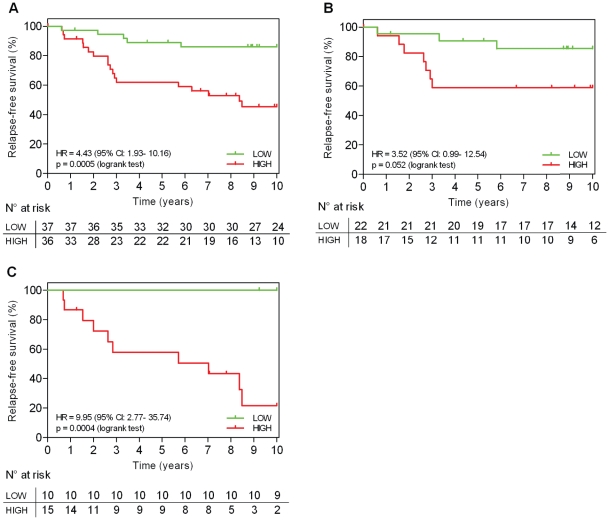
Kaplan-Meier analyses for relapse-free survival according to miR-210 expression levels.(A) Systemically untreated population (N = 73 OXFU); (B) untreated ER-positive population (N = 40); (C) untreated ER-negative population (N = 25). HR: hazard ratio, CI: confidence intervals.